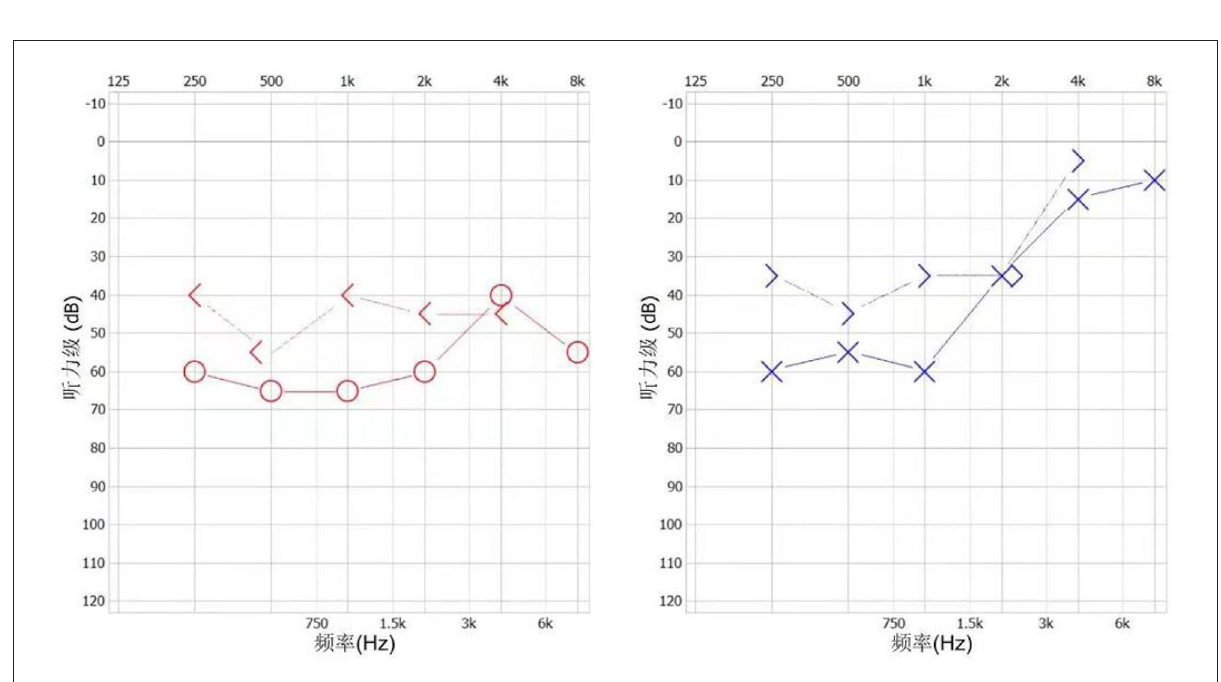
FIGURE2 The patient’s